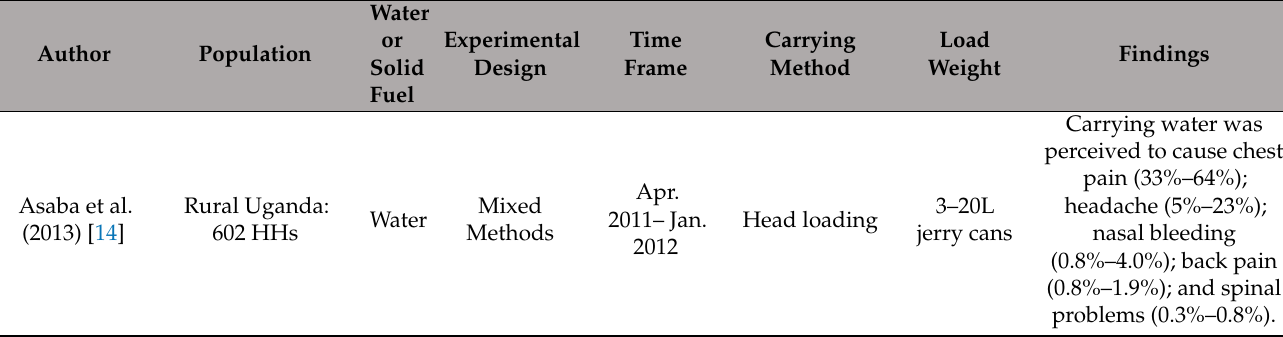
Table A1. Physical impacts associated with water and fuel collection and